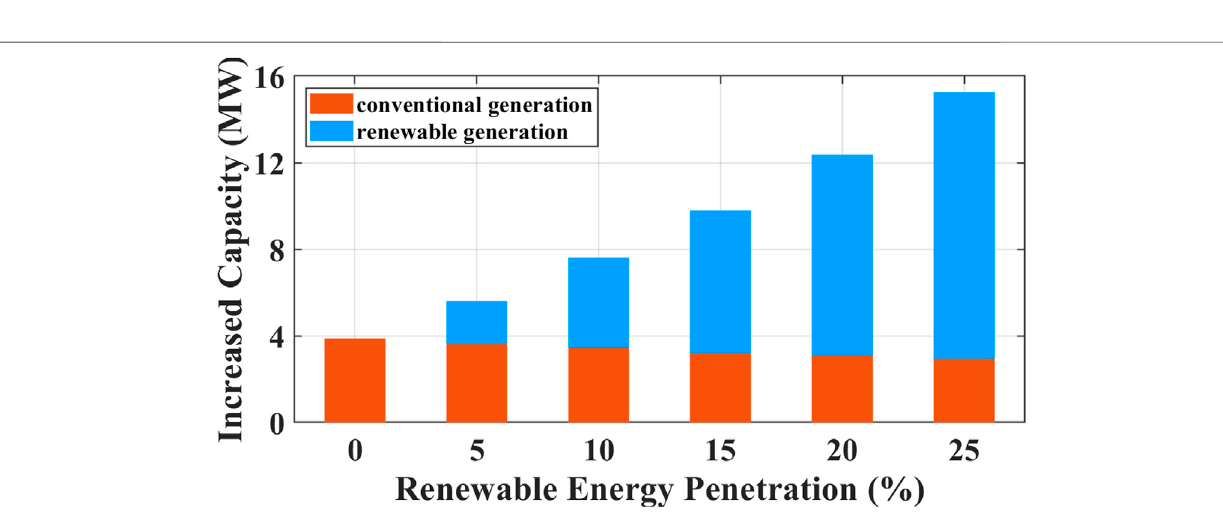
FIGURE 10 | Increased generation capacity at different renewable energy penetrations in Case